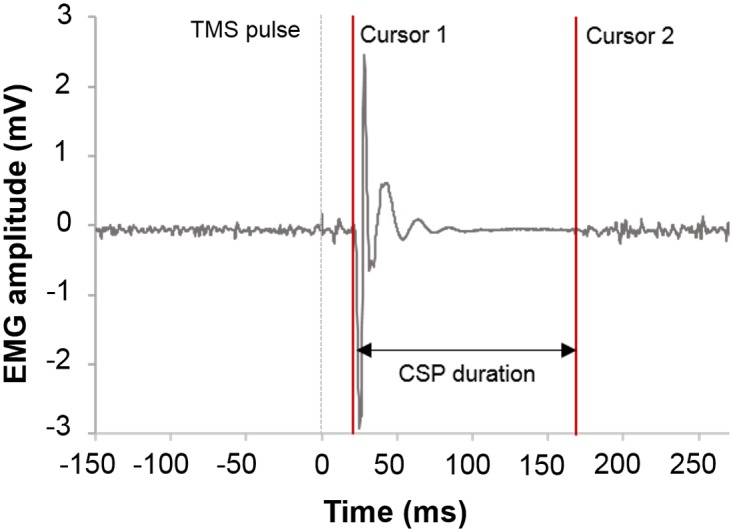
Manual detection of CSP.MEP onset and the subsequent silent period of a single trial are depicted; time from onset of MEP until end of silent period constitute the “CSP duration”. Onset and offset have been marked by setting cursors (red).